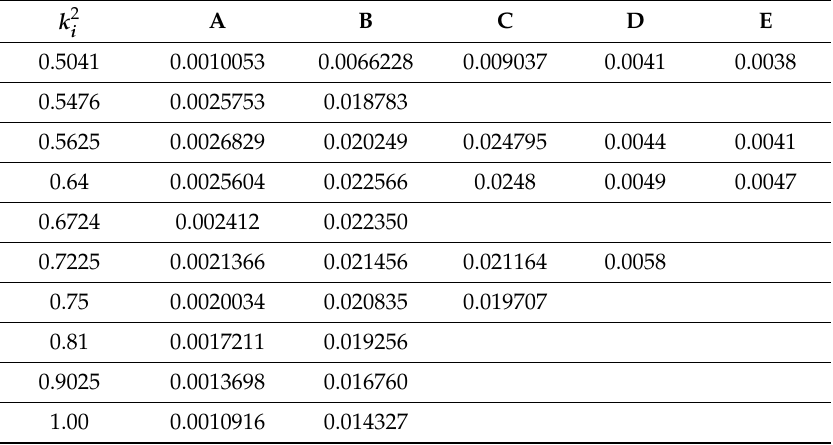
Table 16. Comparison of the cross-sections ( π a 2 ) obtained using the hybrid theory with those obtained 0 in other calculations. A B k 2 i